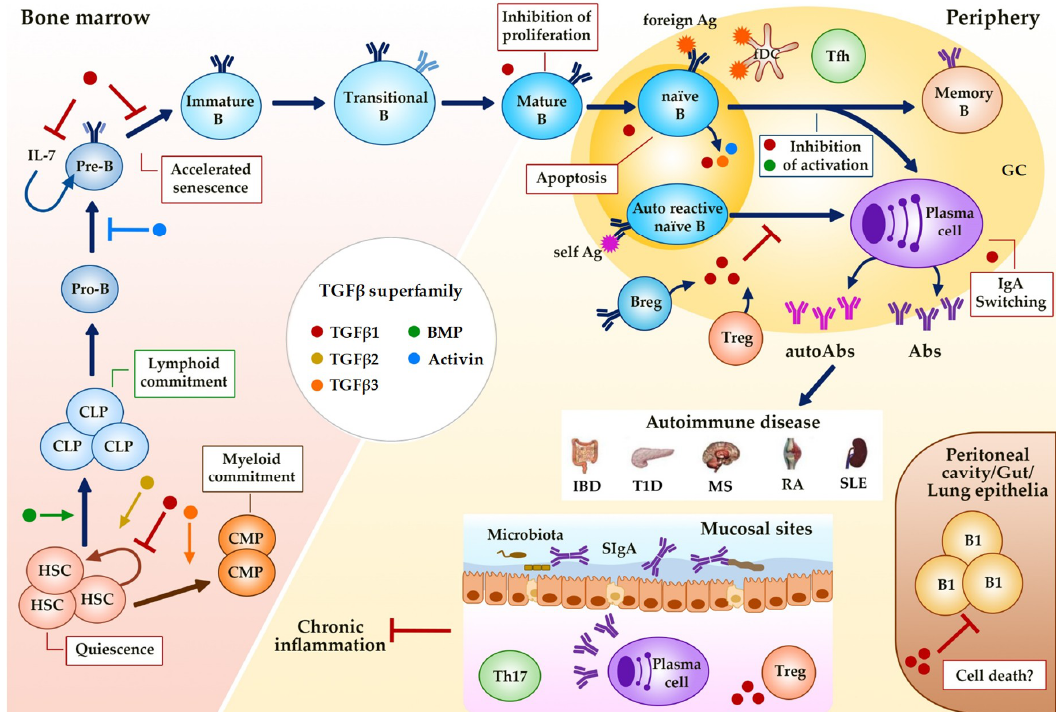
Figure 2. Regulation of B cell development and activity by TGFβ superfamily members. TGFβs, BMPs and activins affect hematopoiesis (quiescence and linage commitment in HSCs) and B cell development (maintenance and senescence of Pre-B cells) in the bone marrow, and immune function at the periphery (proliferation, survival, Ig class switching). Alterations in this regulation could result in different B cell-associated autoimmune diseases. GC (Germinal Center), HSC (Hematopoietic Stem Cell), CLP (Common Lymphoid Progenitor), CMP (Common Myeloid Progenitor), B reg (regulatory B cell), Treg (regulatory T cell), fDC (follicular dendritic cell), Tfh (follicular helper T cell), Ag (Antigen), Abs (Antibodies), SIgA (secretory IgA), IBD (Inflammatory Bowel Disease), T1D (Type 1 Diabetes), MS (Multiple Sclerosis), RA (Rheumatoid Arthritis), SLE (Systemic Lupus Erythematosus). Dark blue arrows show the sequence of B cell precursors during their differentiation in the bone marrow of after the activation of mature B cells in the periphery. The blue arrow, the yellow arrow, the green arrow, the orange arrow, the brown arrow and the red-brown arrow mean activation by the indicated (see color) TGFβ superfamily member. The red ―| and the blue ―| mean inhibition by the indicated (see color) TGFβ superfamily member. Red boxes indicate the activities induced by TGFβ superfamily member indicated by the color of the adjacent dot.